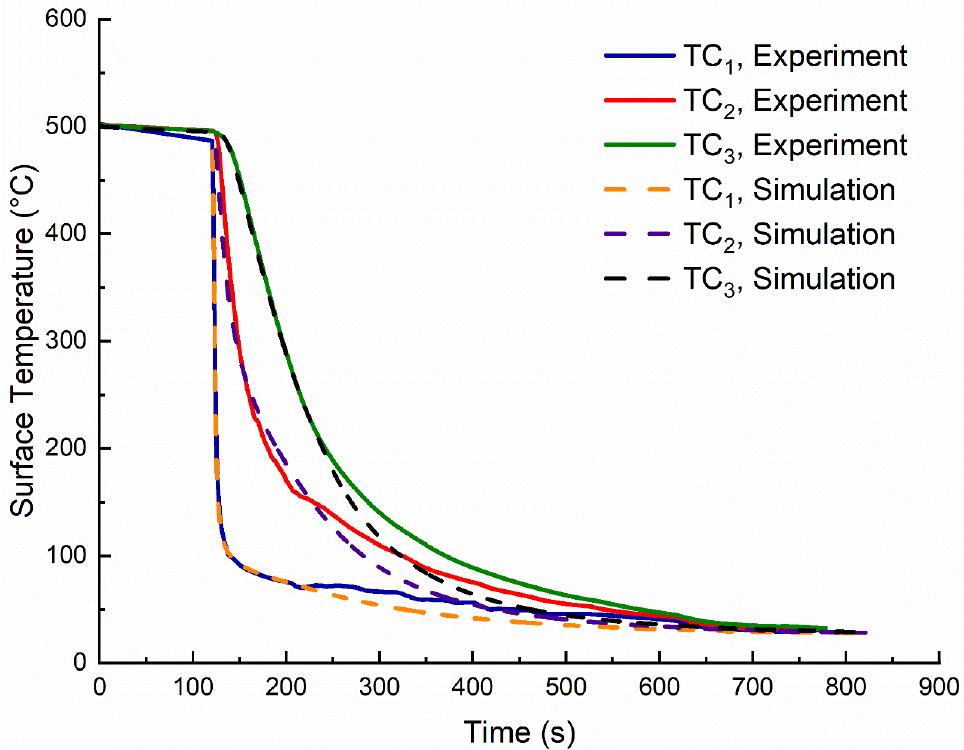
Figure 6. Comparisons between the experimental temperatures recorded by thermocouples and the simulated temperatures.